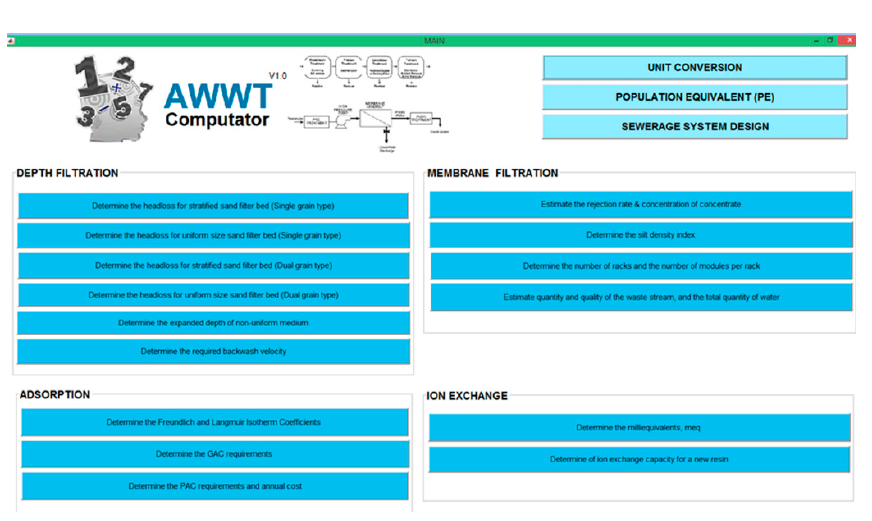
Figure 2. The flow of tool run operation.